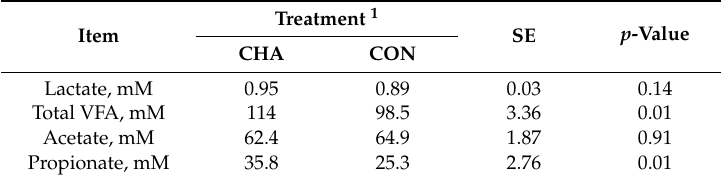
Table 1. Ruminal fermentation variables in beef cattle during the acidosis challenge.